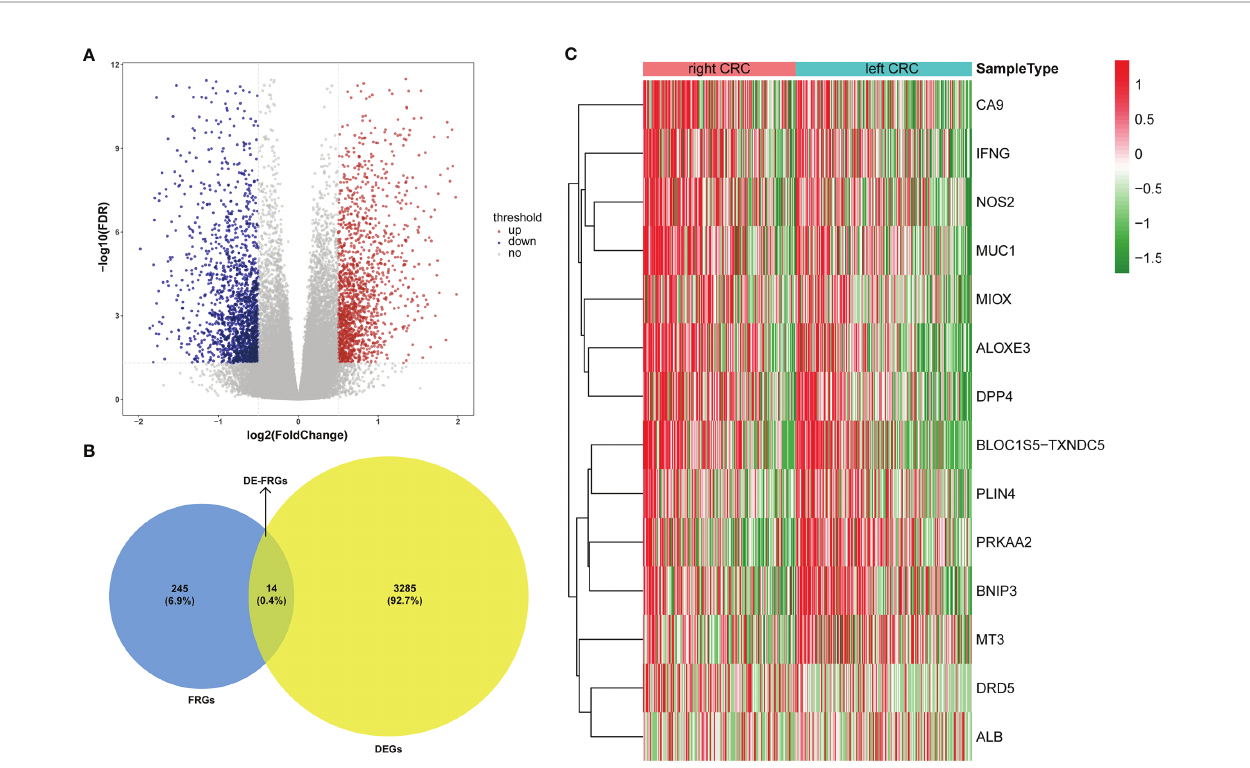
FIGURE 1 | Expression pattern of FRGs between LCRC and RCRC patients. (A) The volcano plots of 3299 DEGs between LCRC and RCRC samples in TCGA database, with the cut-off criteria of |log2 FC| > 0.5 and P < 0.05. Red plots: upregulation; blue plots: downregulation; gray plots: normally expressed genes. (B) The Venn diagram shows the intersecting genes from DEGs and FRGs. Blue area: FRGs; yellow area: DEGs; cross area: DE-FRGs. (C) The heatmap of 14 DE-FRGs between LCRC and RCRC groups. Genes with higher expression were shown in red, while lower expressions were shown in